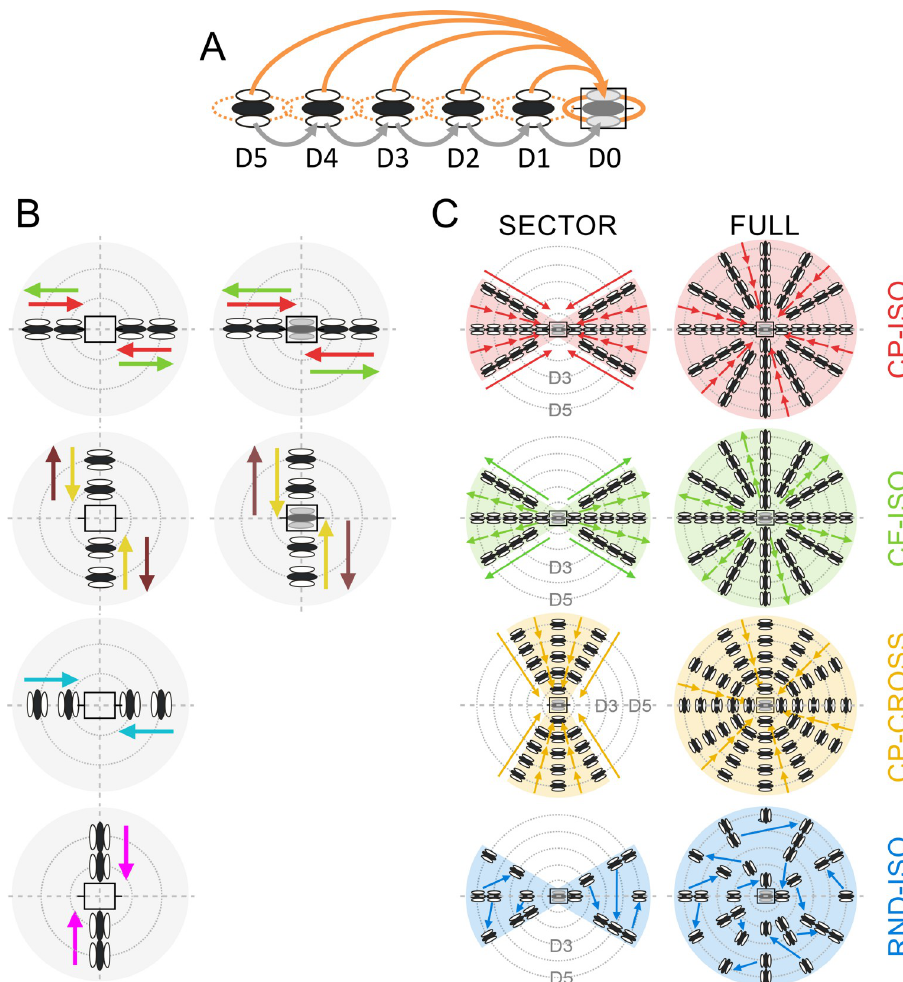
Fig 1. Working hypothesis and visual stimulation protocols. (A) : Working Hypothesis : the AM sequence is designed so as to synchronize the synaptic activation time of horizontal volleys, evoked by the sequential presentation of 2 to 5 Gabor patches (GP) in the Surround, with the feedforward activation of the RF Center (shaded rectangle in the D0 position). The Surround GPs, regularly spaced from “Far” (D5) to “Near” (D1) periphery along the apparent motion path (horizontal axis), are flashed in succession at high contrast. The test reference GP, terminating the AM sequence, is flashed at low/medium contrast in the RF center (D0). Each orange arrow represents the lateral propagation of the presynaptic volley elicited by each distal GP. Other synaptic recruitment paths potentially also contribute also to Surround-Center modulation, in particular cascades of proximal neighbor-to-neighbor links (grey arrows). (B) “Cardinal” Protocol : the two columns illustrate the exploration of the two cardinal axes (horizontal for the RF orientation preference; vertical for the RF width axis) with 2 or 3-stroke AM sequences of ISO-oriented stimuli (“collinear”, first row; “parallel”, second row) or CROSS-oriented stimuli (two bottom rows, same motion paths but the local inducer orientation is now orthogonal to the RF orientation preference). (C) : “Radial” Protocol : the two columns illustrate the various AM flow patterns (individual rows), either funnelled along a given motion axis ( SECTOR , left), radially contracting (CP: centripetal) or expanding (CF:centrifugal), or across the full Surround ( FULL , right). In the SECTOR condition, two opposite motion axes are symmetrically explored, aligned either with the RF orientation preference (horizontal axis ( ± 30˚) in rows 1, 2 and 4) or with its width axis (vertical axis ( ± 30˚), row 3). In the FULL condition, all directional motion axes (discretized by 30˚ steps) are stimulated concurrently and intersect the RF center (horizontal grey icon). From top to bottom, each row illustrates one specific configuration of AM flow: 1) centripetal collinear flow ( CP-ISO ) from Surround to Center (red, 1 st row); 2) centrifugal collinear flow ( CF-ISO ) from Center to Surround (green, 2 nd row), 3) centripetal cross-oriented flow ( CP-CROSS ) across the RF width axis (gold, 3 rd row); 4) randomized collinear pattern ( RND-ISO ) where each successive GP location has been randomized in space and time (blue, bottom row). Note that in all the conditions other than CF-ISO, the last GP of the sequence is flashed with the optimal orientation in the RF center (D0). See Text for